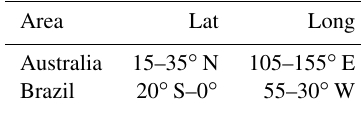
Table 2. The geoinformation of Brazil and Australia. Area Lat